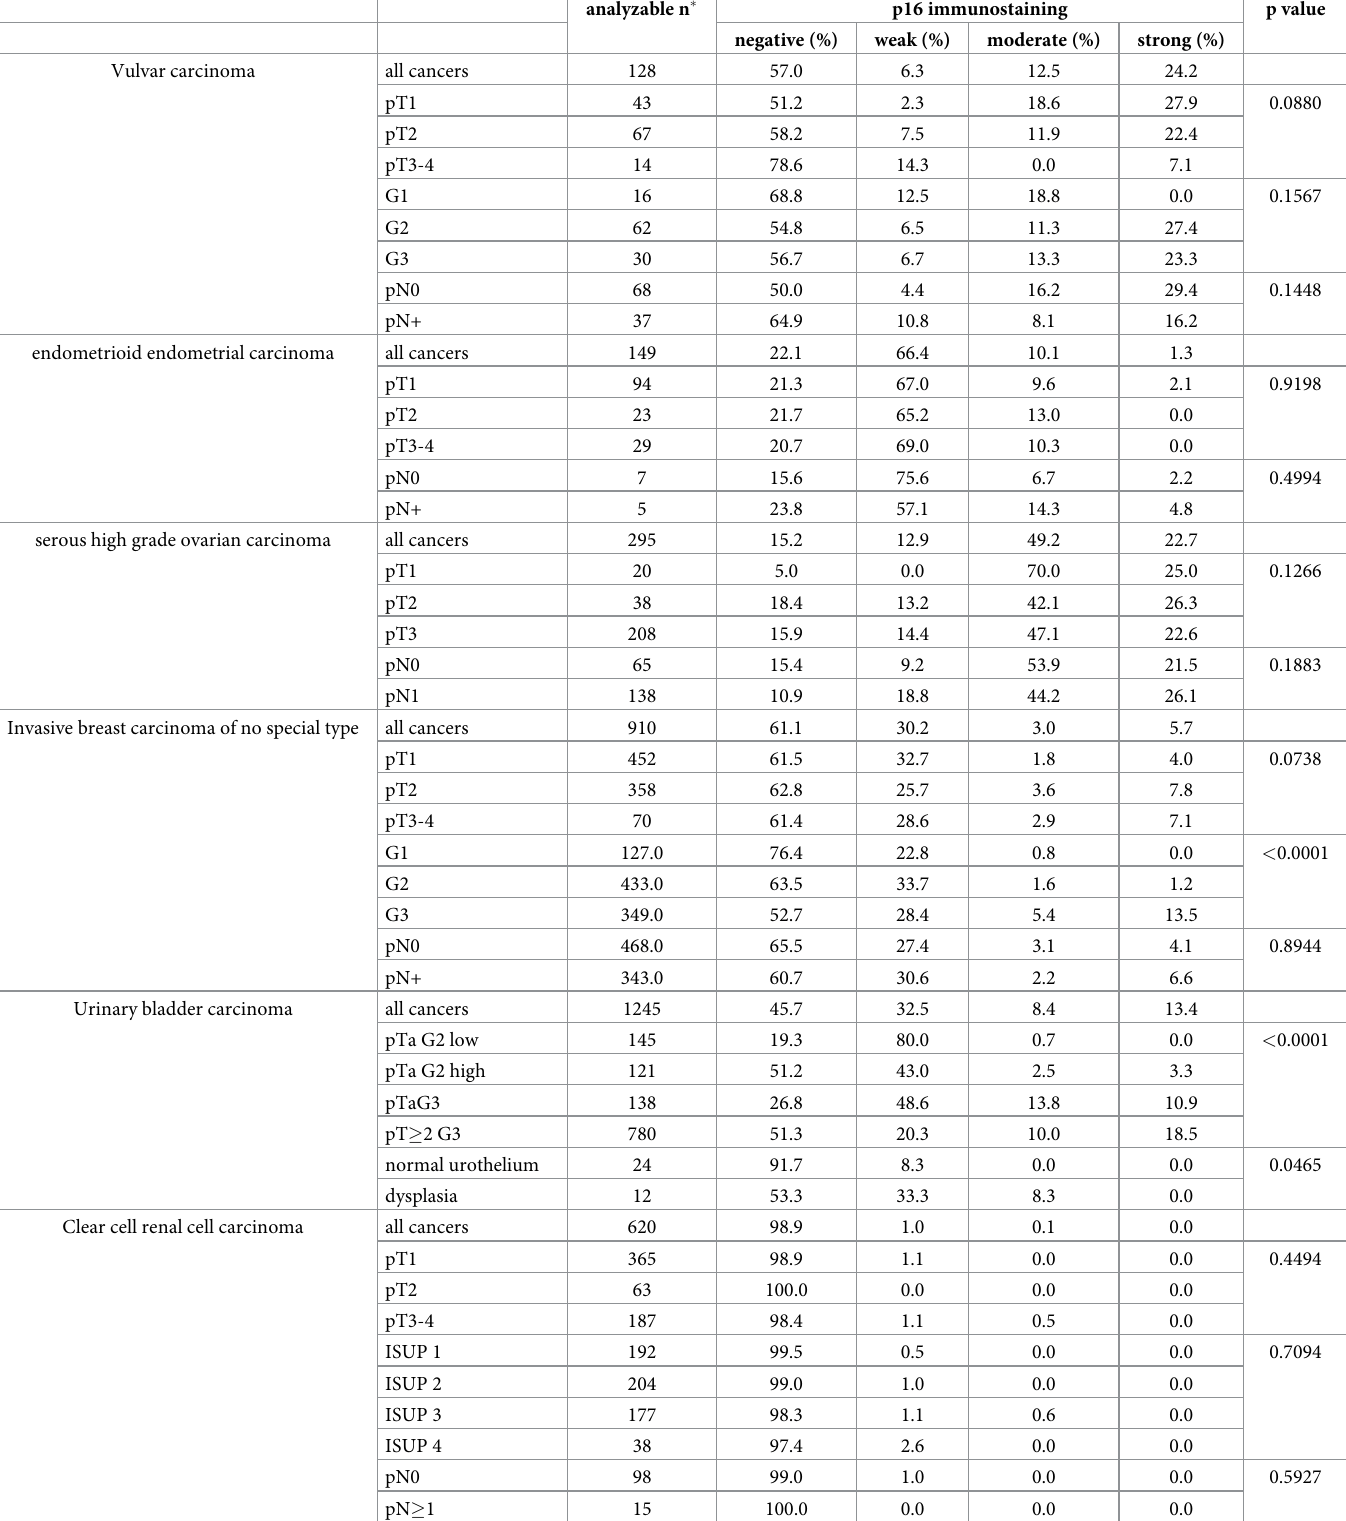
Table 2. p16 immunostaining and tumor